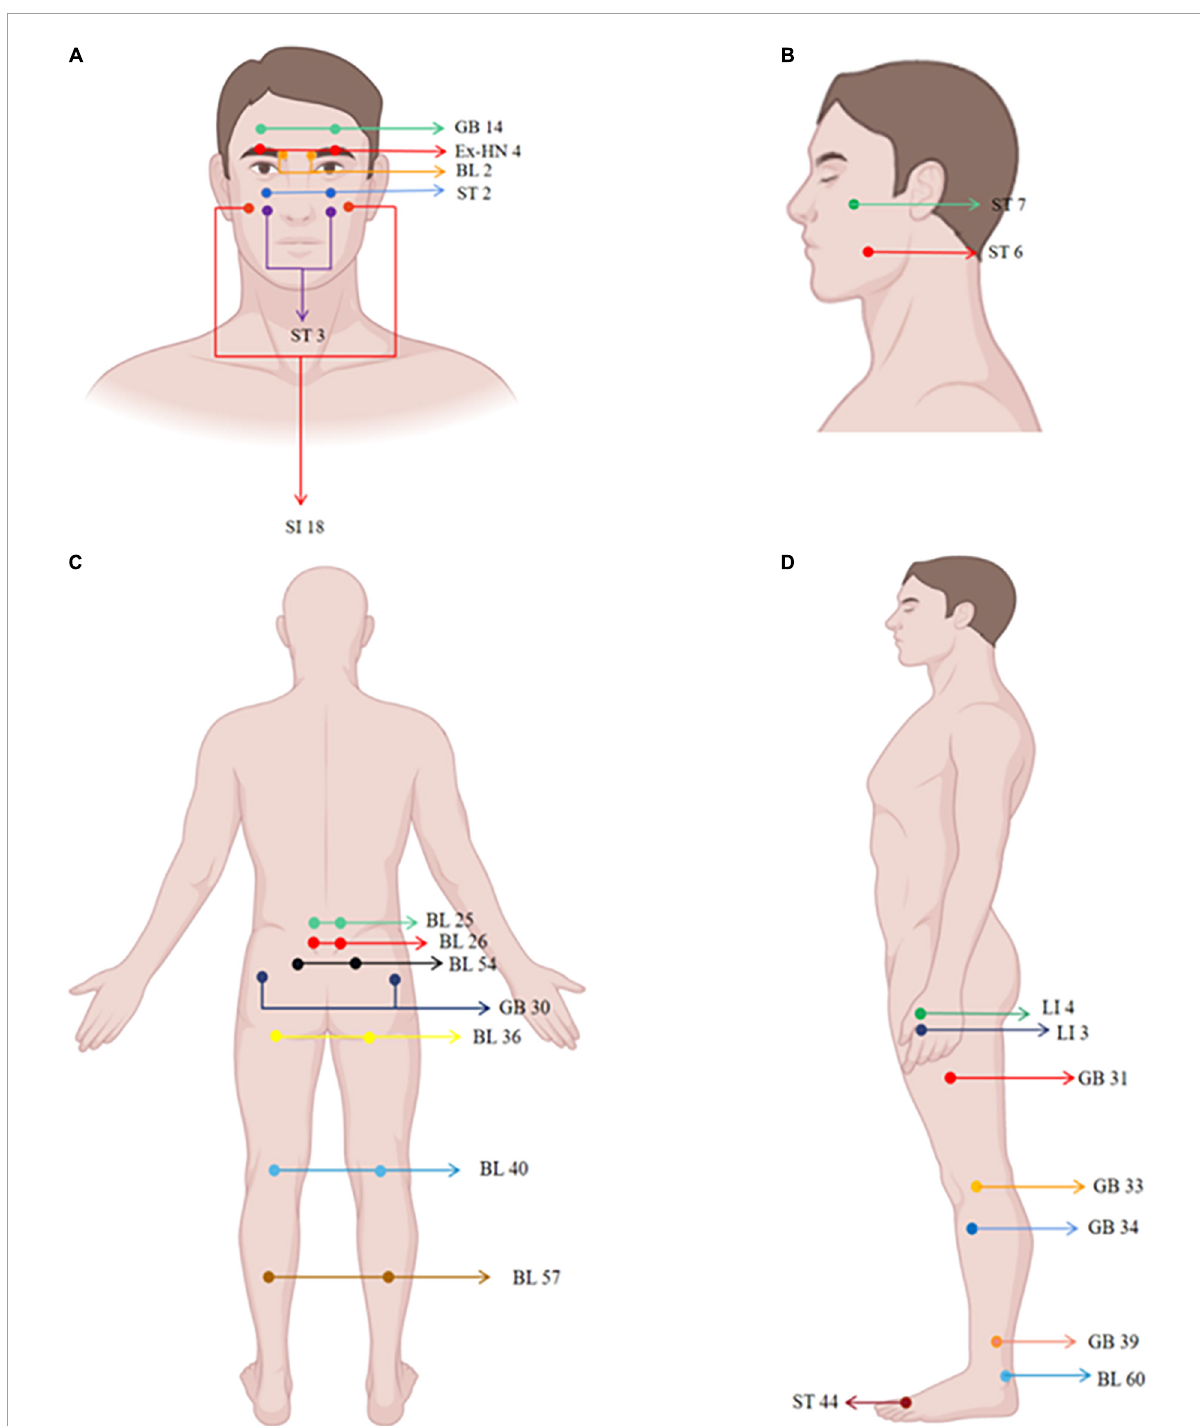
FIGURE2 Human maps of acupoints used in neuropathic pain studies. The locations of acupoints are marked in the figure.